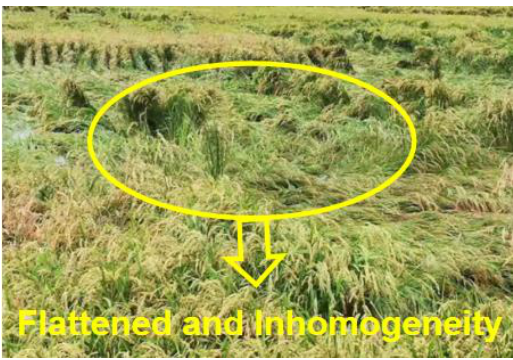
Figure 2. Uneven density of crop growth.